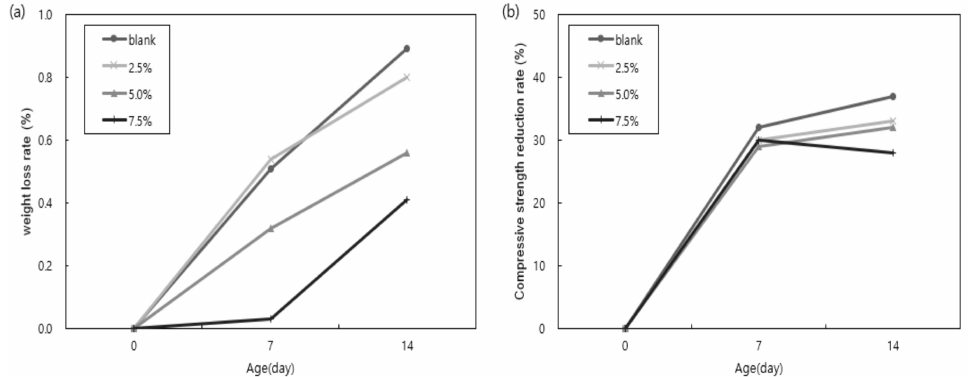
Figure 6. Weight loss rate ( a ) and compression strength reduction rate ( b ) by immersion time in the aqueous sulfate solution. ( a ) is the weight loss rate after 7 days and 14 days. (b ) is the rate of decrease in compressive strength after 7 days and 14 days.